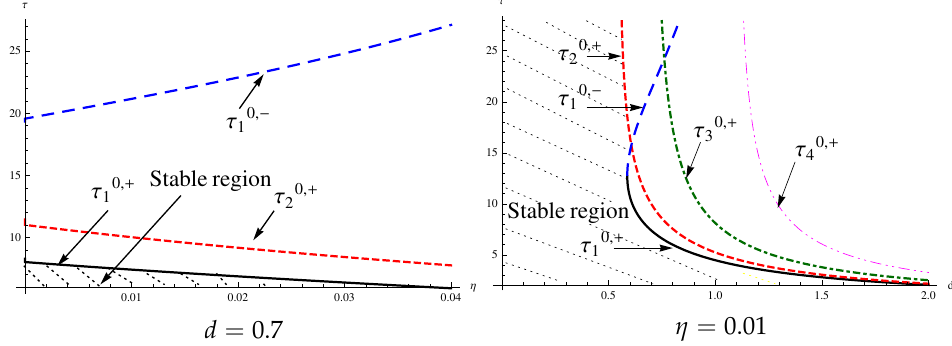
Figure 3. Bifurcation diagram of system (2) with parameter η ( Left ) and d ( Right ).